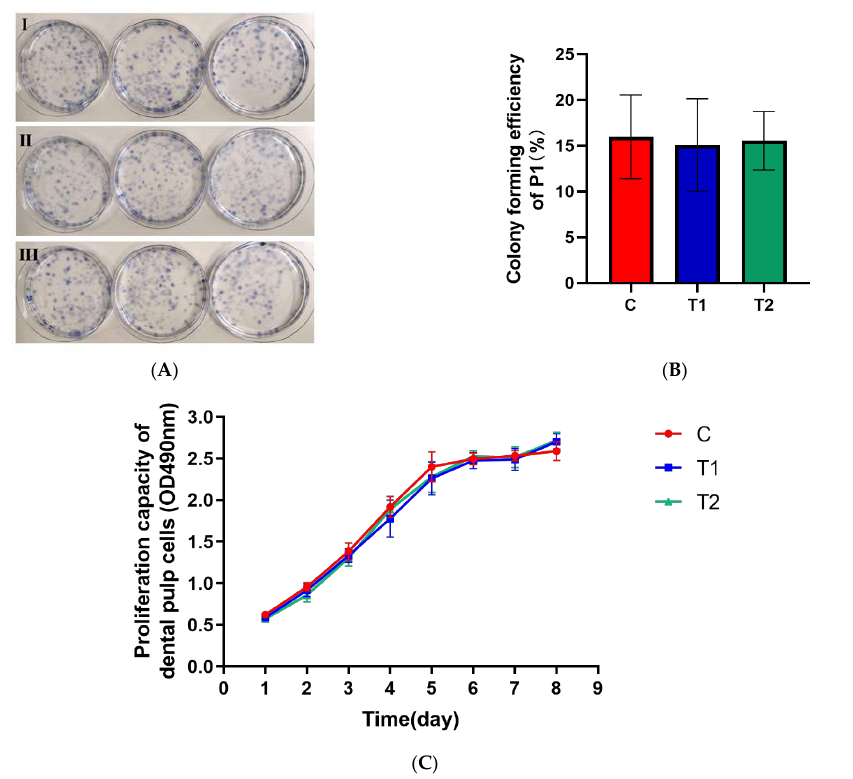
Figure 5. Proliferation ability of primary dental pulp cells in each group. ( A ) Giemsa staining results of dental pulp cells. Ⅰ : C group; Ⅱ : T1 group; Ⅲ : T2 group. ( B ) Colony-forming efficiency. ( C ) Cell growth curve (MTS assay).